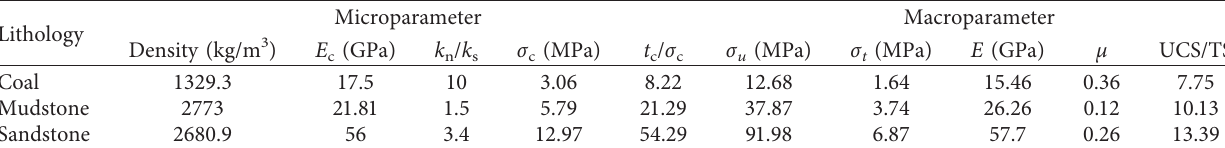
Table 2: Macroparameter and microparameter